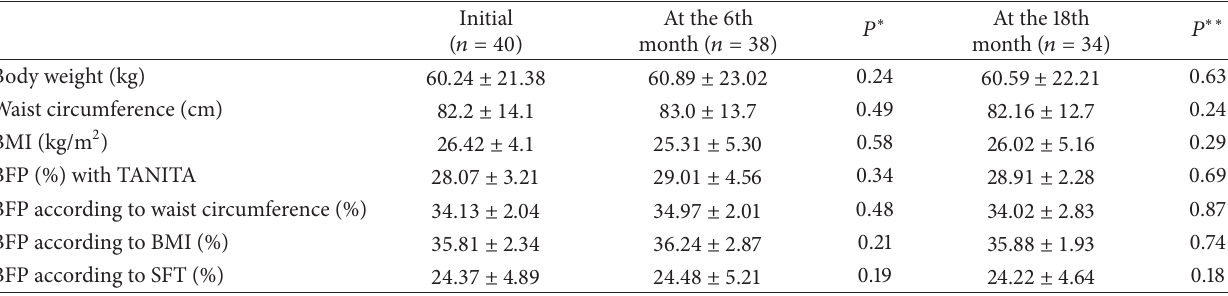
Table 2: The characteristics of control subjects during follow-up.